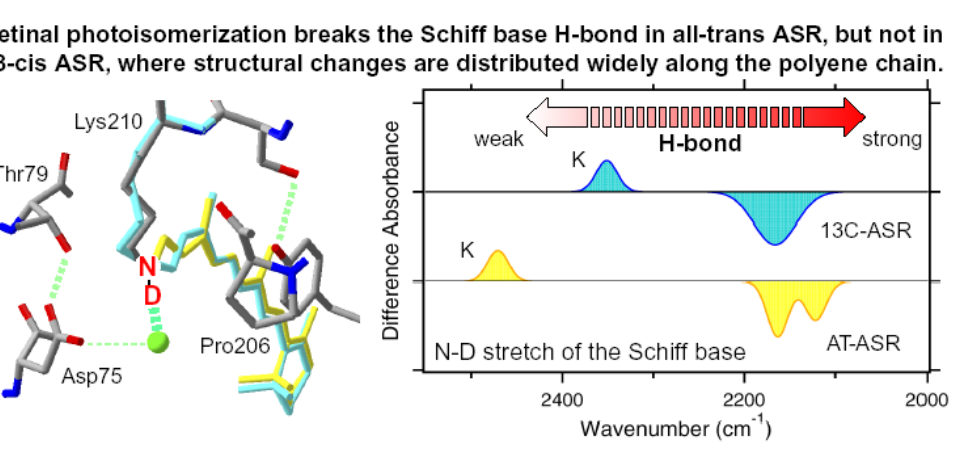
Figure 21. (Left) The X-ray structure around retinal Schiff base. Yellow retinal is all- trans form and blue retinal is 13- cis form. (Right) The diagram of the ASR spectra in X-D vibration region. It shows only N-D stretch of the Schiff base. This figure is reprinted with permission from TOC of Kawanabe et al [59]. Copyright 2006 American Chemical